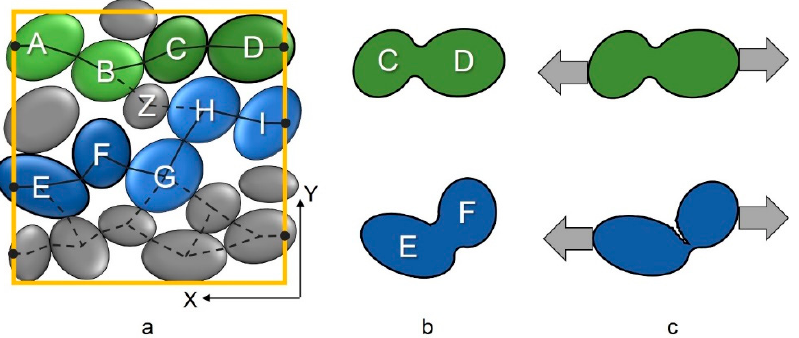
Figure 12. ( a ) Possible solid paths in X-direction in one analyzed square; ( b ) sintered particles of paths A → D and E → I; and ( c ) possible reactions of sintered particles when stressed in X-direction.